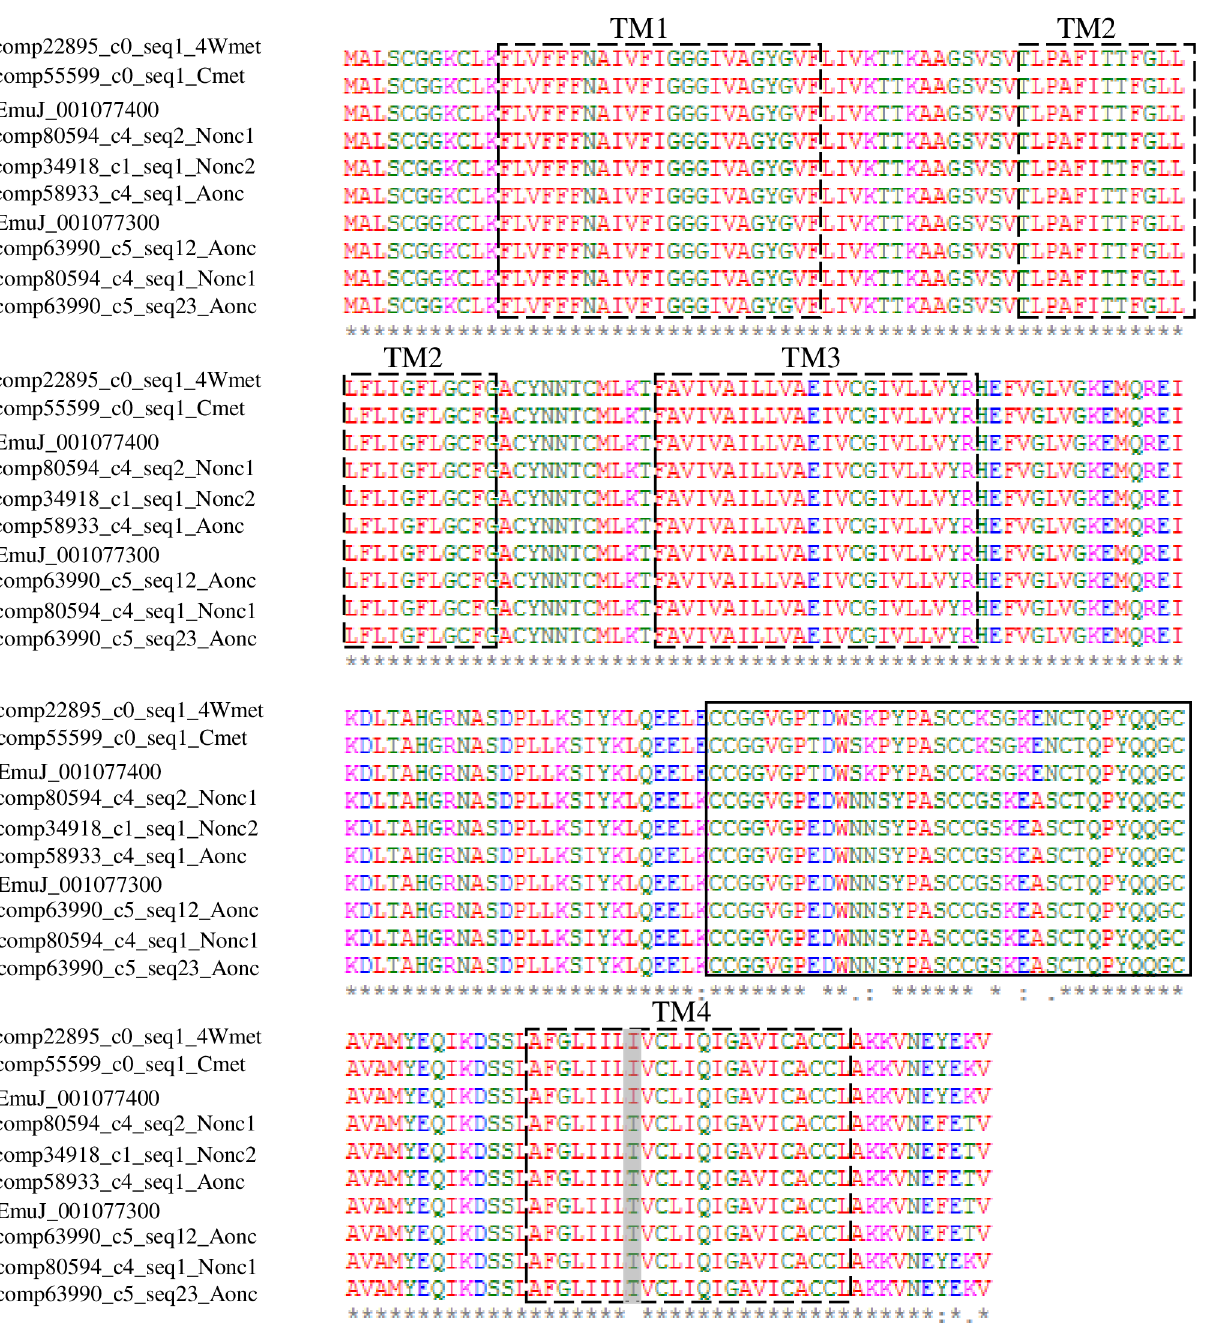
Fig 6. Protein alignment of putative Em-TSP3 isoforms with four transmembrane. Fully conserved residues are marked with ( * ), those replaced with amino acids of strongly similar properties with (:) and of weakly similar properties with (.) LEL variable region are in the solid line box and predicted transmembrane region are in the dashed line box. Protein mutant of the forth transmembrane is shaded in grey. There are three Em-TSP3 isoforms predicted, two of them are conserved with previous study [23], but one of them are intermediate type of the former two isoforms and need further verification.